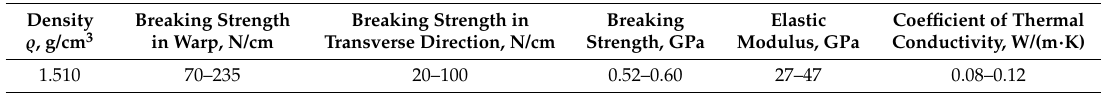
Table 3. Mechanical properties of UTM-8-1s carbon